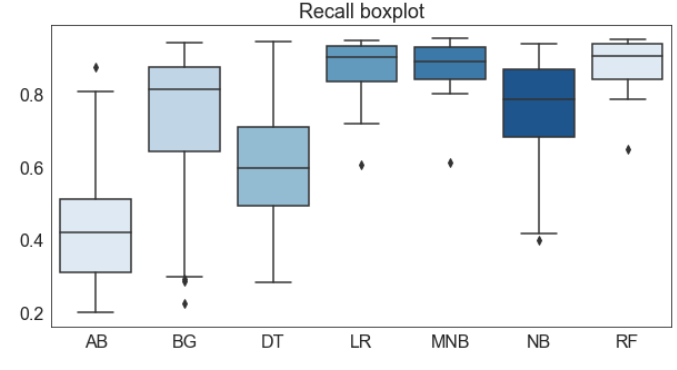
Figure 12. Recall boxplot.